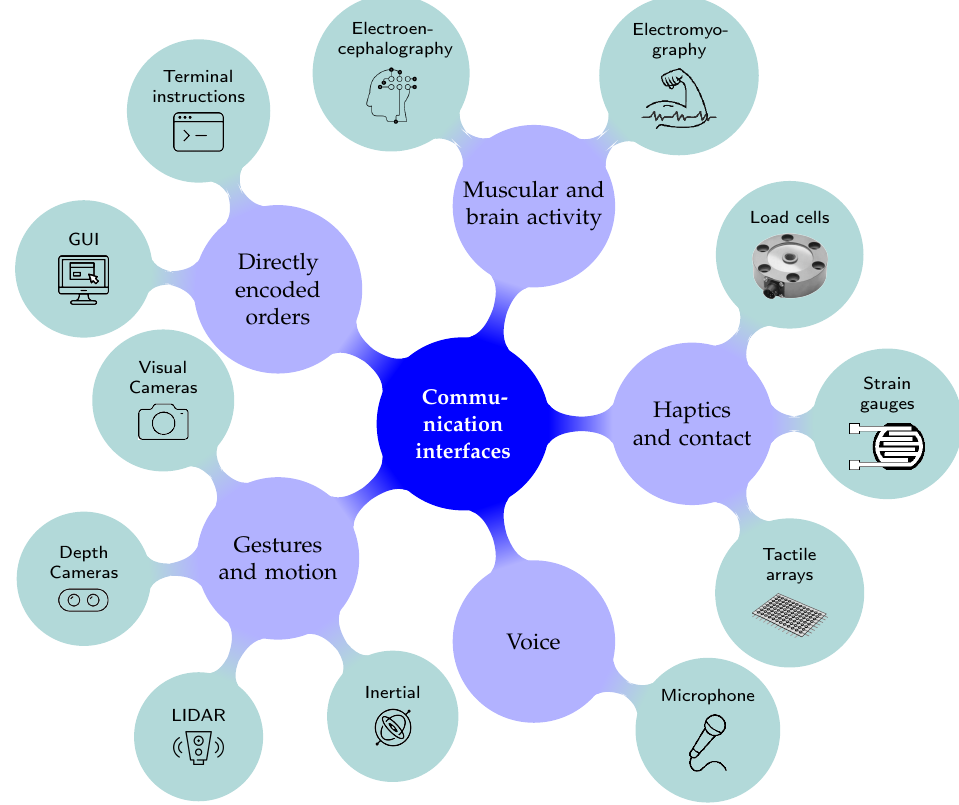
Figure 3. Overview of communication interfaces for HRC and some associate base